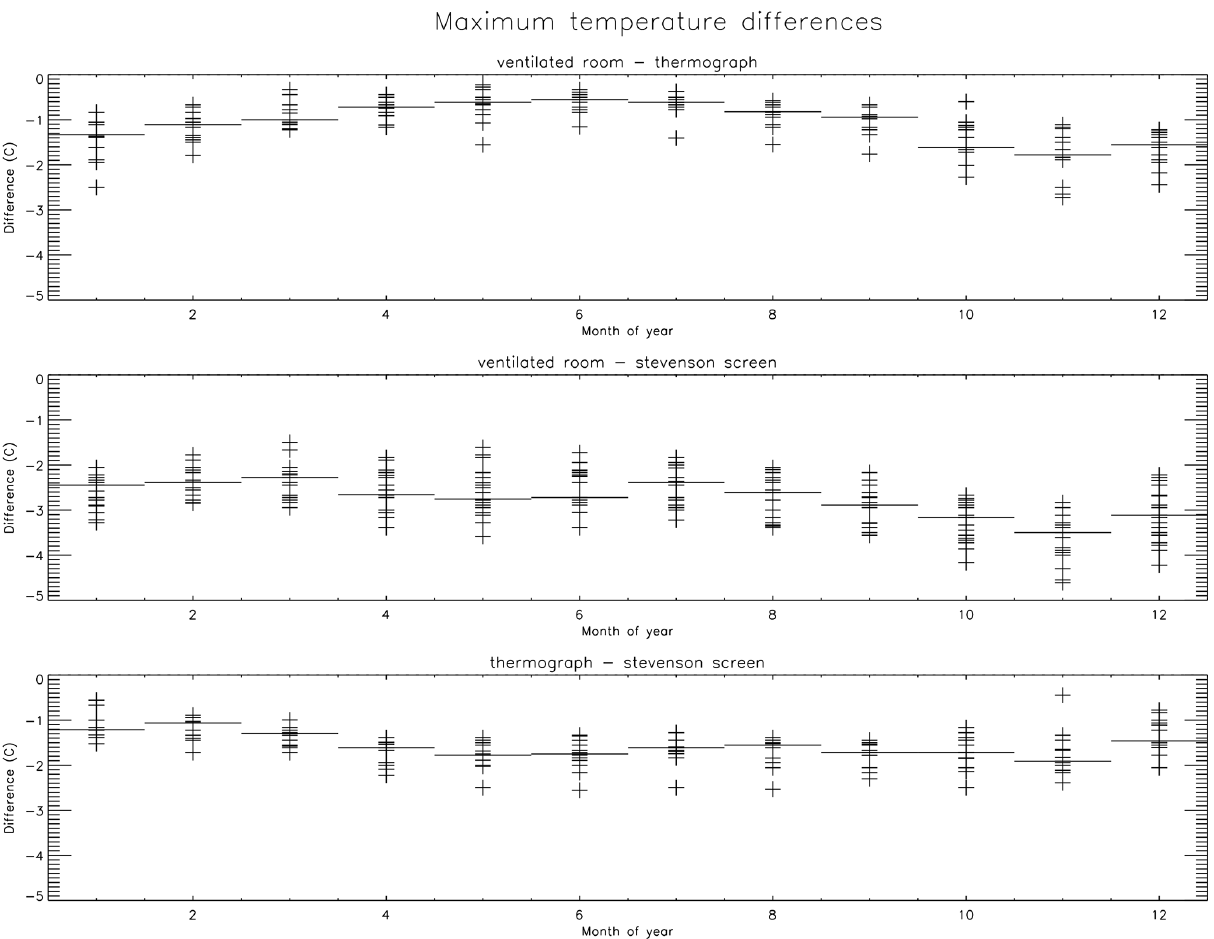
Figure 12. Monthly distribution of the differences between the different instrument pairs to the extent each series is available (Figs. 9 and 10). Each individual value is specified by a cross, and the median of all values is denoted by the solid horizontal line for each calendar month. Vertical axes are kept identical between panels for comparison